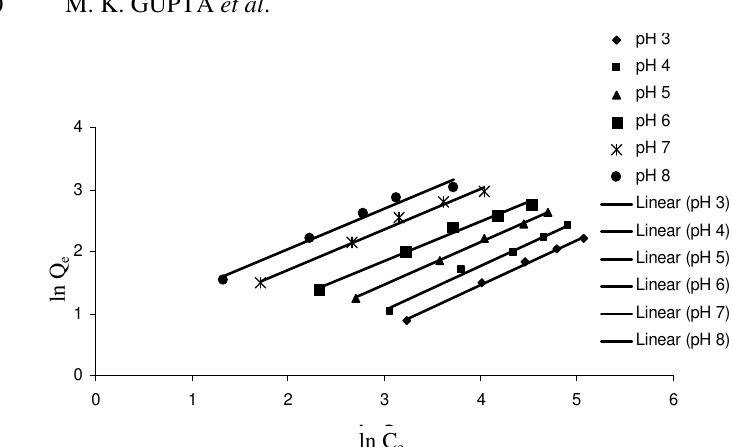
Figure 3 . Linearized Freundlich isotherms at different solution pH